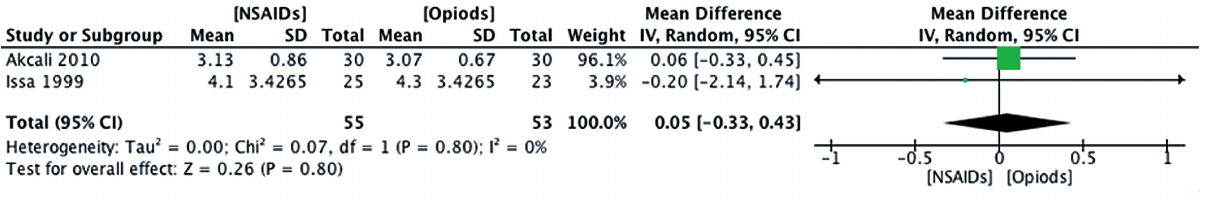
figure 4 - comparison between nsAIDs and opioids, adequate analgesia